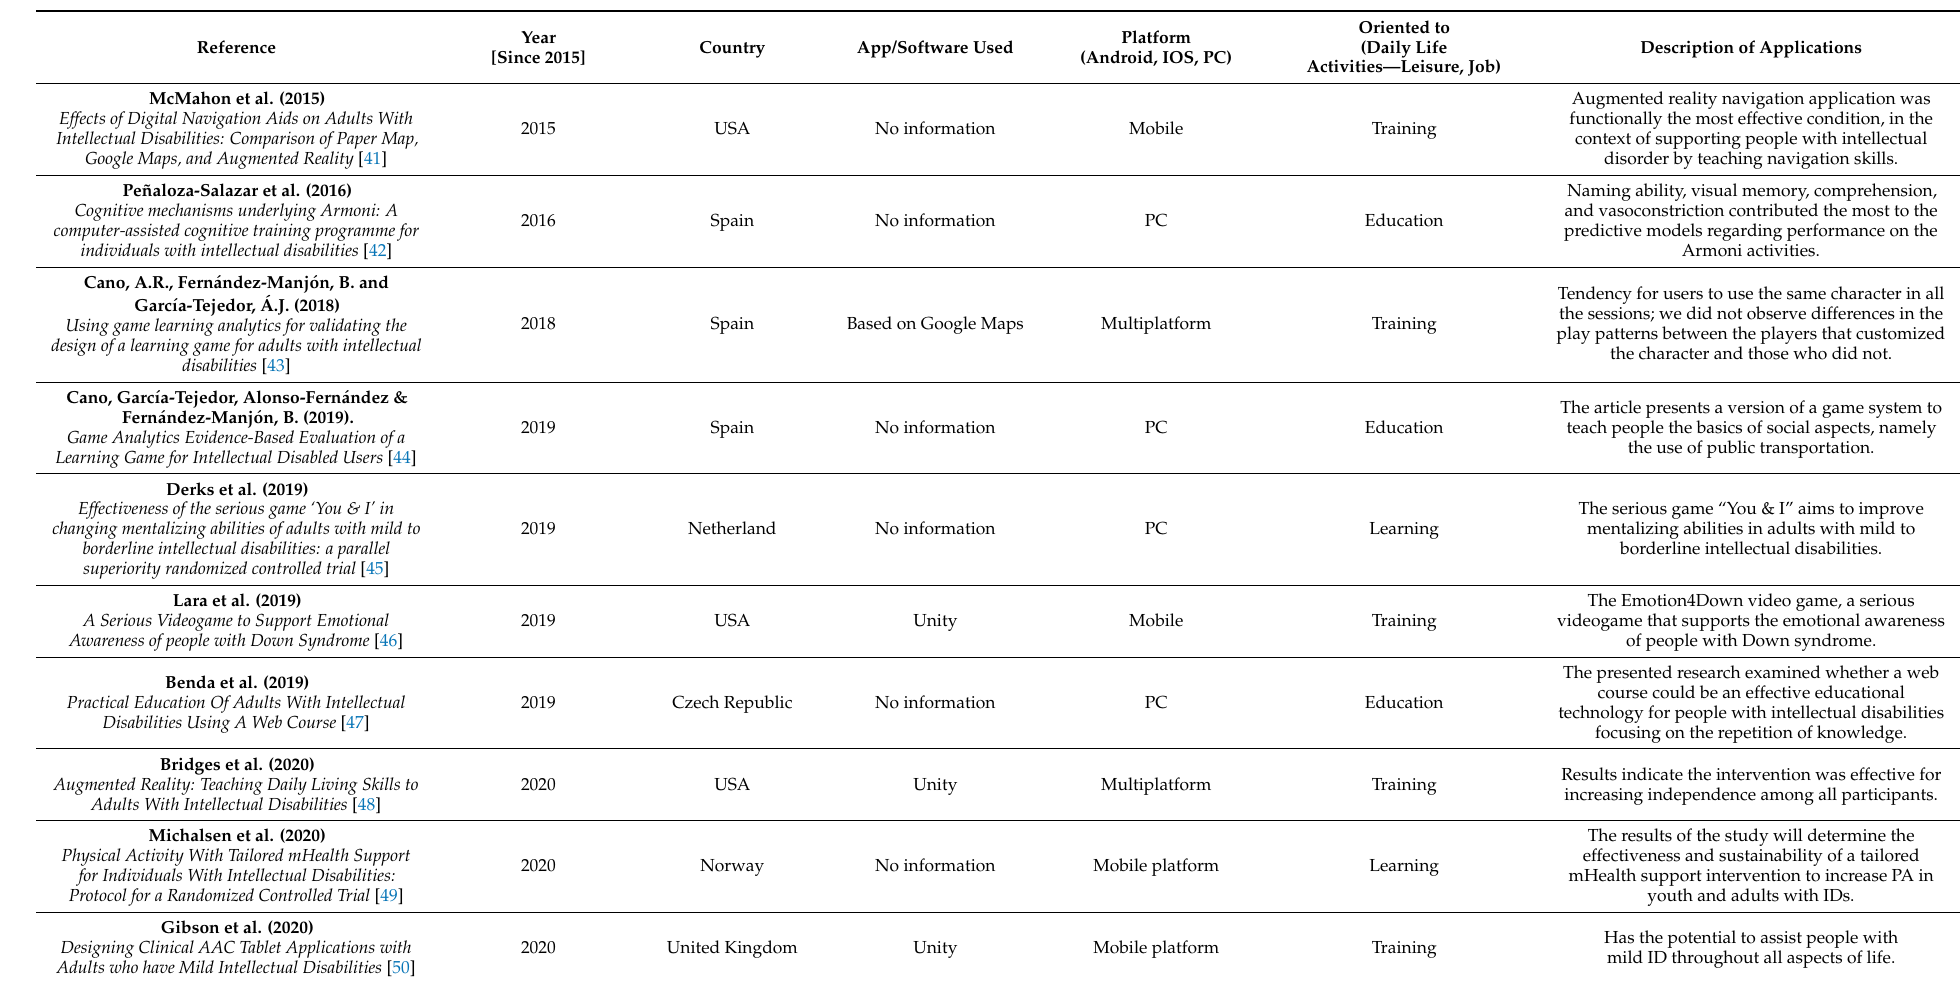
Table 5. Main review of studied